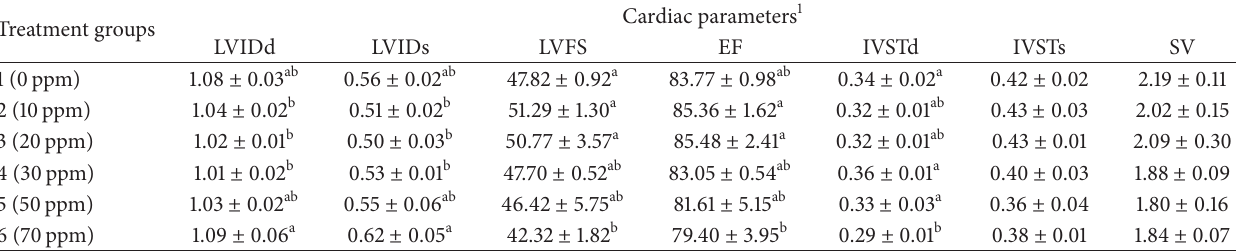
Table 1: Comparison of echocardiographic indices (Means ± Standard deviation) among different chicken groups treated with nanoparticles. Treatment groups